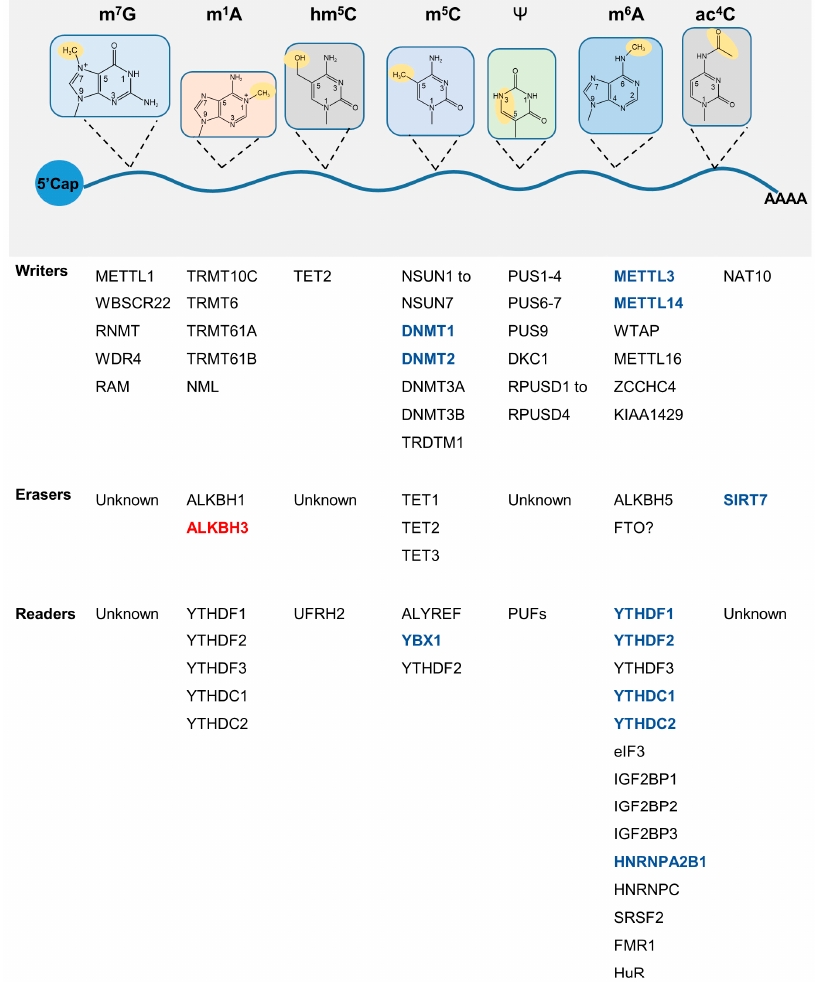
Figure 3. RNA modification and senescence. Seven types of RNA modifications have been stud- ied thus far, including m 7 G, m 1 A, m 6 A, m 5 C hm 5 C, ac 4 C, and Ψ . A summary of the writer, eraser, and reader proteins of the related modifications is presented. Aging-related changes: red represents upregulation, while blue represents downregulation. M 7 G, 7-methylguanosine; m 1 A, N 1-methyladenosine; m 5 C, 5-methylcytosine; hm 5 C, 5-hydroxymethylcytidine; m 6 A, N 6-methyladenosine; Ψ , uri- dine-to-pseudouridine.